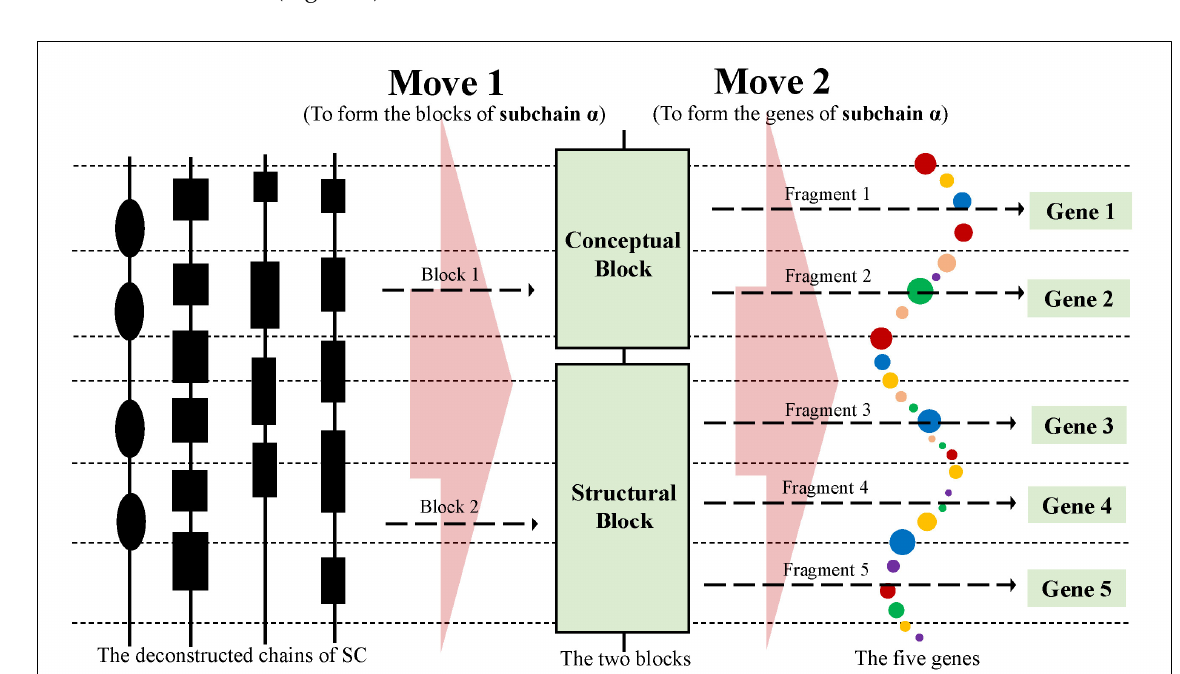
Figure 7. The logic expression from the reconstructed chains to the DNA Subchain α .